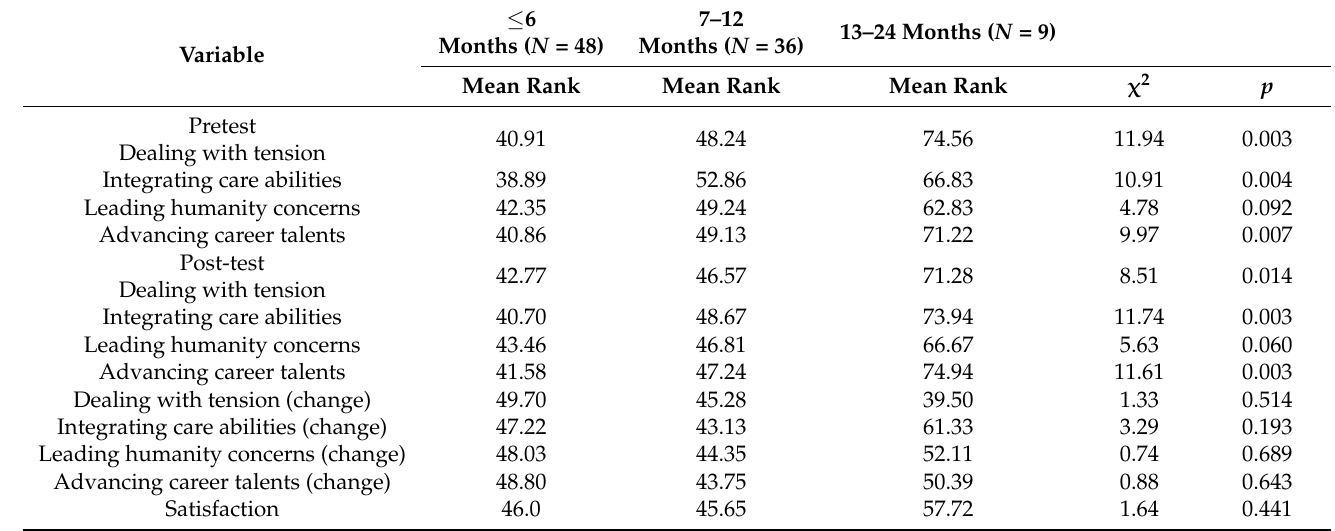
Table 4. Difference in core competencies by length of nursing experience ( N =